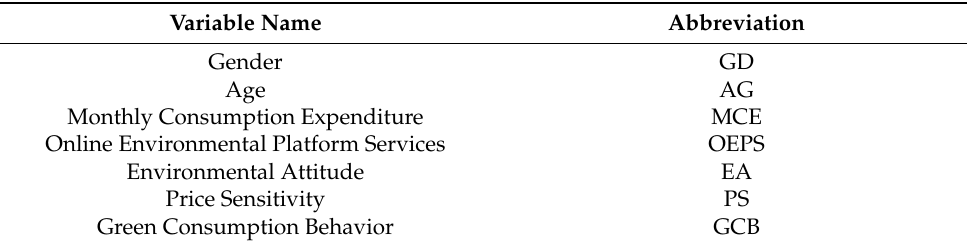
Table A1. Abbreviation for variable